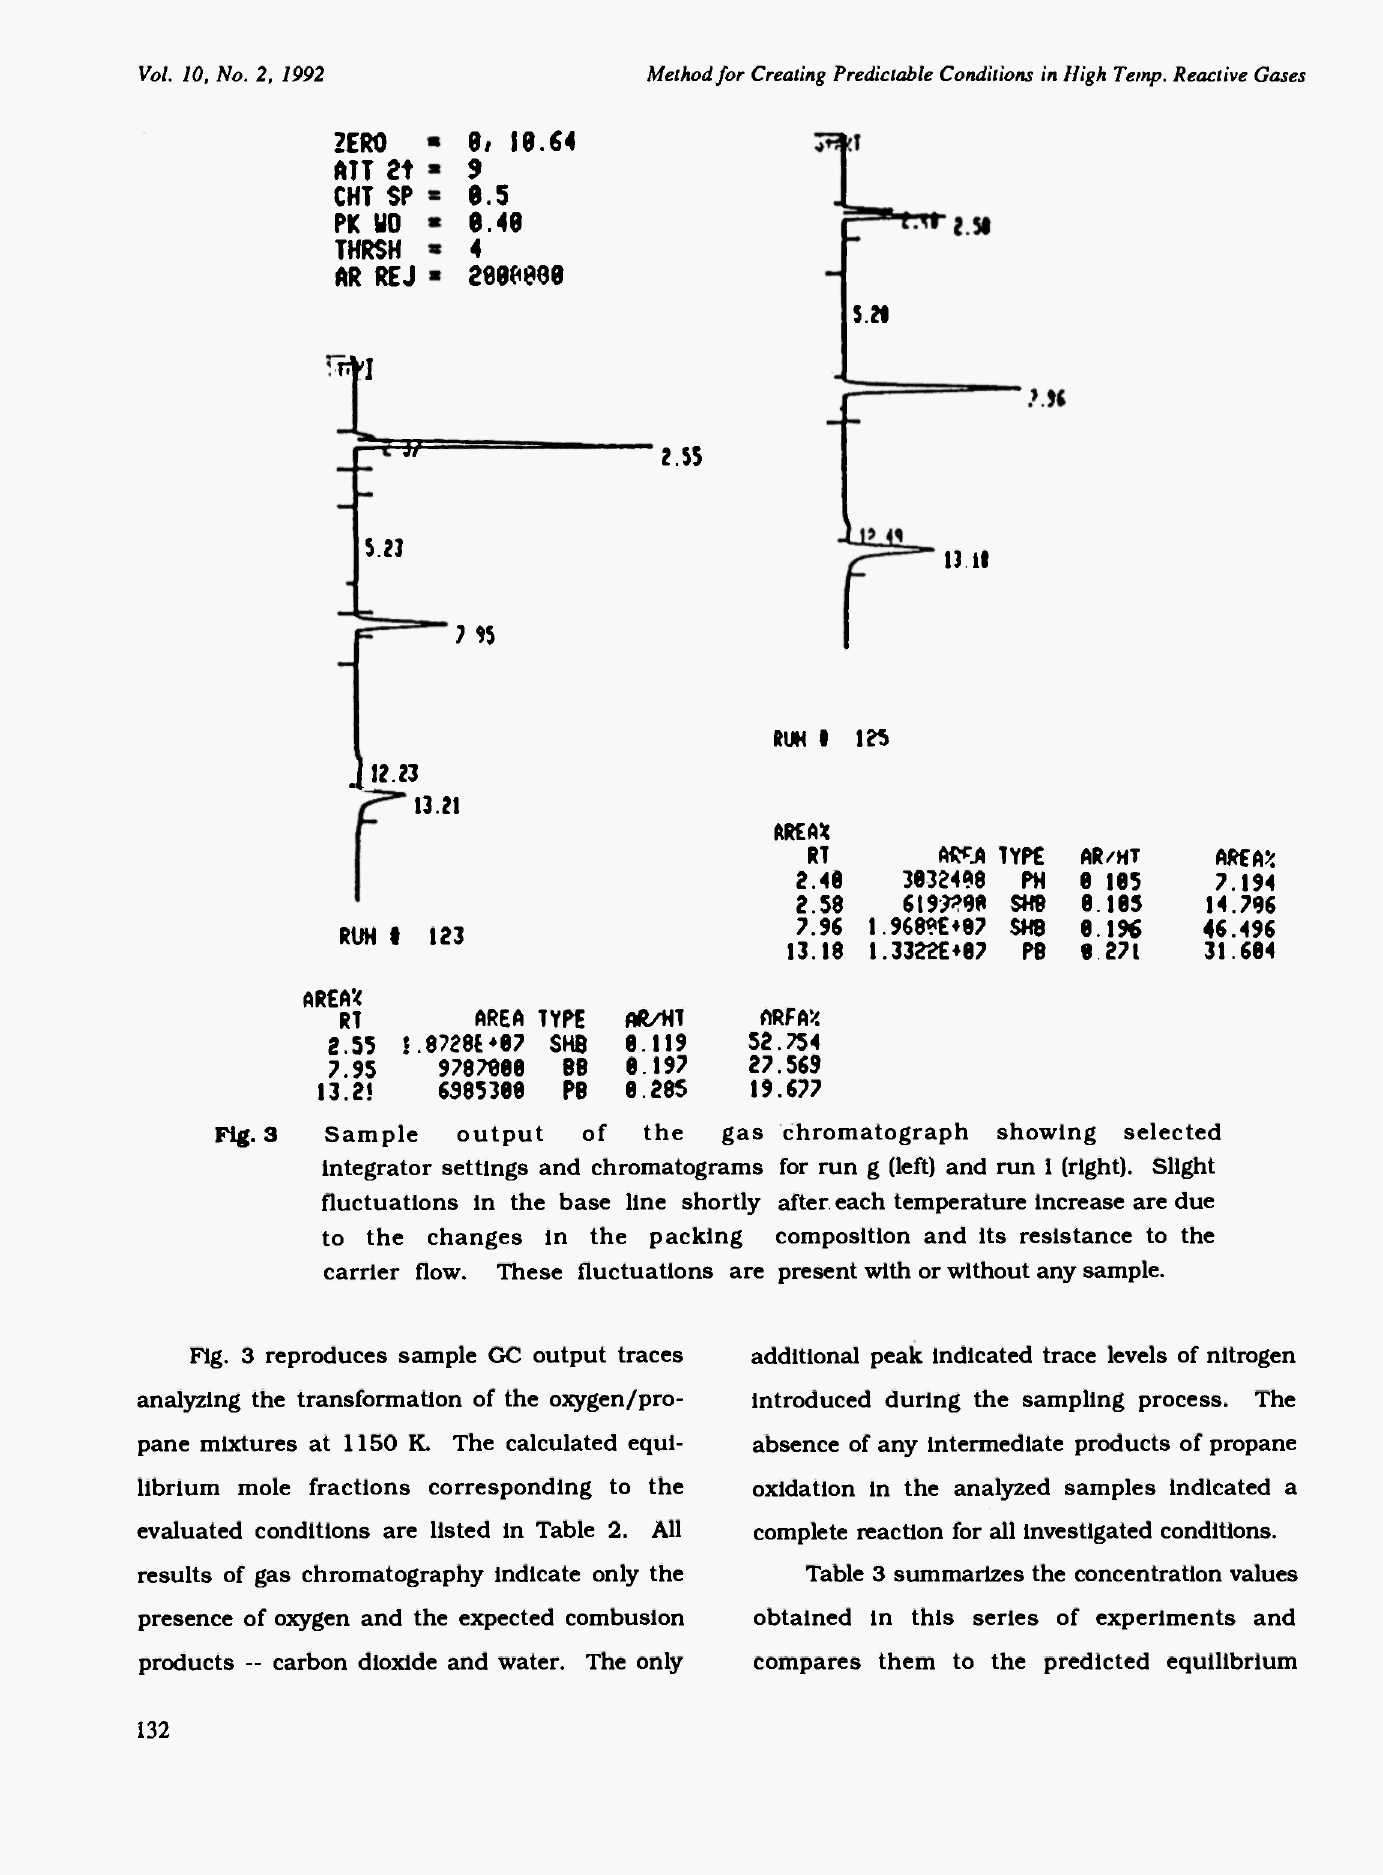
Fig. 3 reproduces sample GC output traces analyzing the transformation of the oxygen/pro- pane mixtures at 1150 K. The calculated equi- librium mole fractions corresponding to the evaluated conditions are listed in Table 2. results of gas chromatography indicate only the presence of oxygen and the expected combusion products — carbon dioxide and water. The